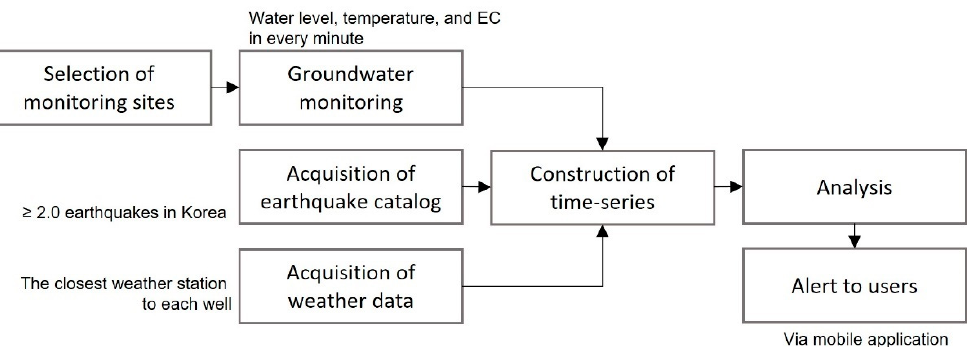
Figure 2. The flowchart of the pilot-scale pseudo-real-time groundwater monitoring system established in this study.